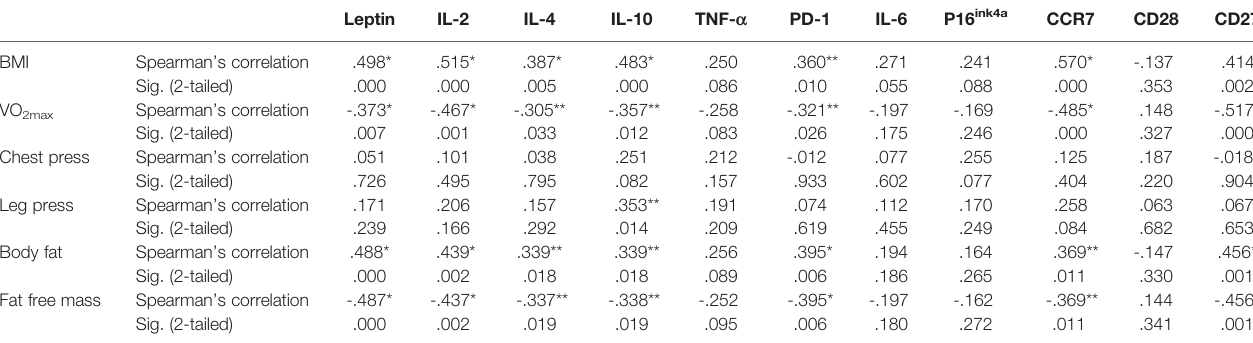
TABLE 3 | Correlations between physical fi tness and body composition with gene expression of the immunosenescence markers of obese diabetic (OBD) or Obese without associated disease (OB) or Eutrophic (E) middle-aged individuals. Leptin IL-2 IL-4